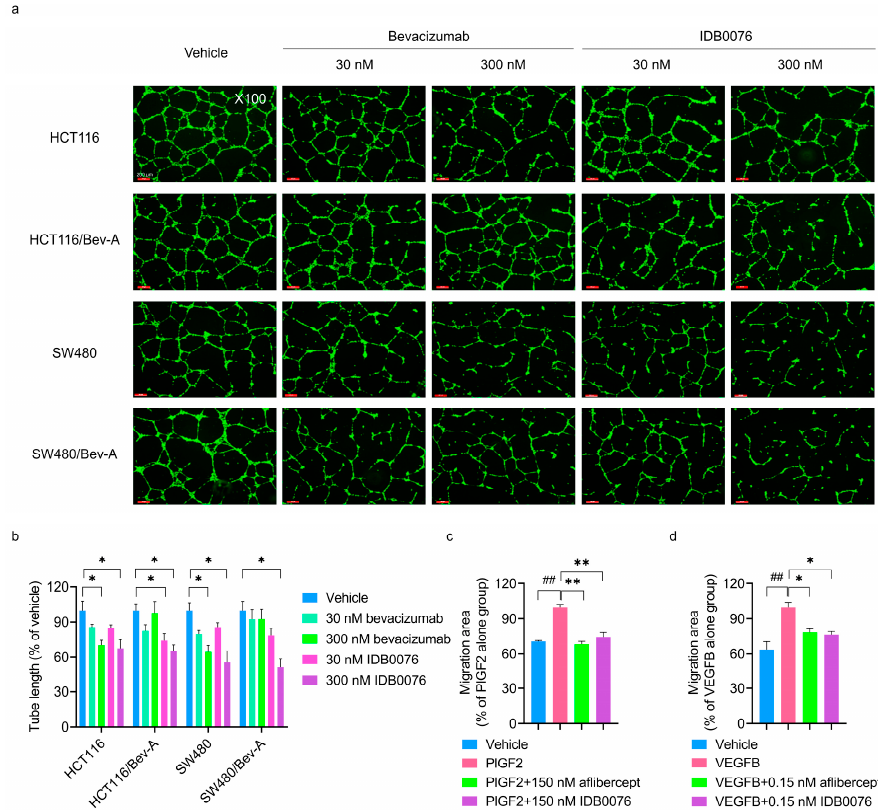
Figure 2. IDB0076 suppresses angiogenic e ff ects of multiple proangiogenic growth factors in human umbilical vein endothelial cells (HUVECs). ( a , b ) IDB0076 inhibited the tube formation by HUVECs stimulated by the conditioned medium (CM) derived from the parental cells (HCT116 and SW480 cells) or bevacizumab-adapted cells (HCT116 / Bev-A and SW480 / Bev-A cells) treated with vehicle, IDB0076, or bevacizumab for 24 h, followed by the induction of tube formation for 24 h. Representative images out of three independent experiments are shown. The results were quantified by measurement of tube length using an angiogenesis analyzer. Data are presented as mean ± SEM ( n = 3); * p < 0.05 as compared with the vehicle group treated with the CM derived from each cancer cell line. Scale bars = 200 µ m, × 100 magnification. ( c , d ) IDB0076 inhibits PlGF2- or VEGFB-induced HUVEC migration comparably to aflibercept. Under starvation, cell monolayers were scratched and treated with the indicated concentration of IDB0076 or aflibercept in the presence of either PlGF2 or VEGFB. After that, the area of migration into the scratch was determined. Data are presented as mean ± SEM ( n =